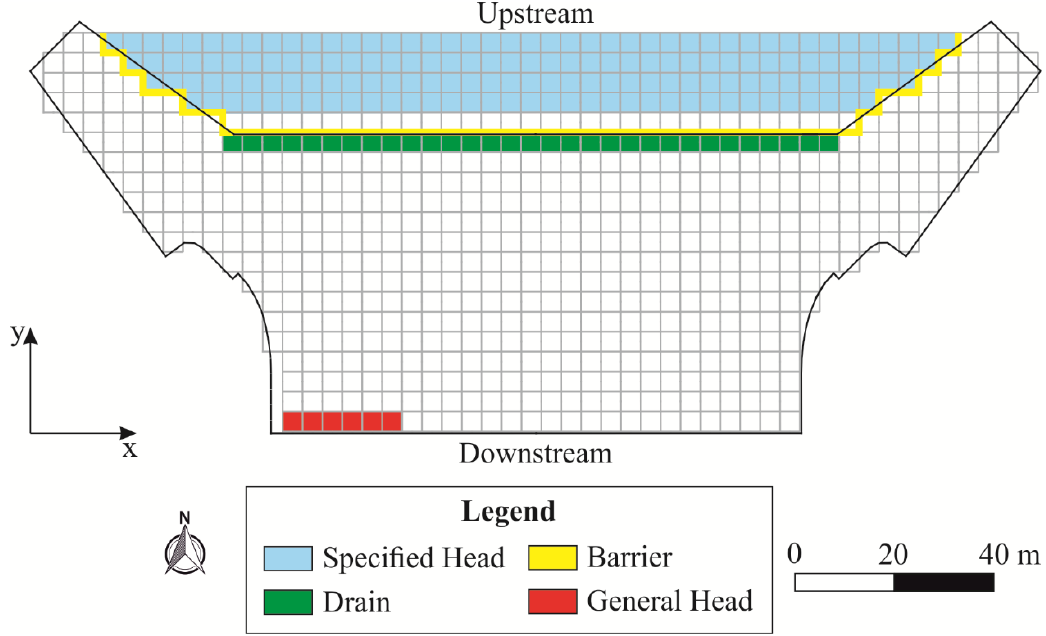
Figure 3. Model grid and types of boundary conditions. The black line is the external boundary of the dam and the stilling basin; the gray lines represent the computational grid used to model the study area.